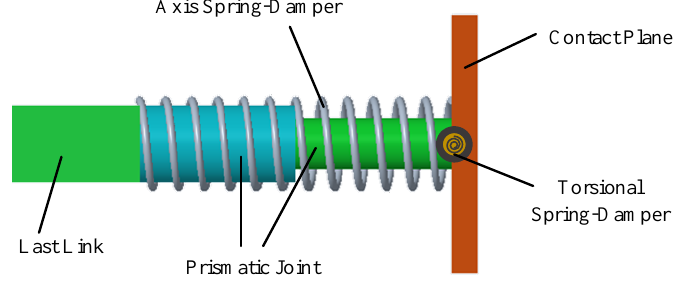
Figure 2. Schematic of the end-effector.